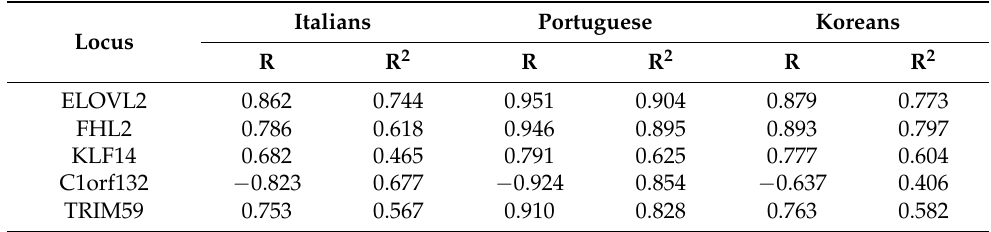
Table 3. Comparison of age correlation values in blood samples from individuals of Italian, Portuguese, and Korean ancestry. For all populations, the analysis was performed at the same CpG sites. Italians Portuguese Koreans Locus R R 2 R R 2 R R 2 ELOVL2 0.862 0.744 0.951 0.904 0.879 0.773